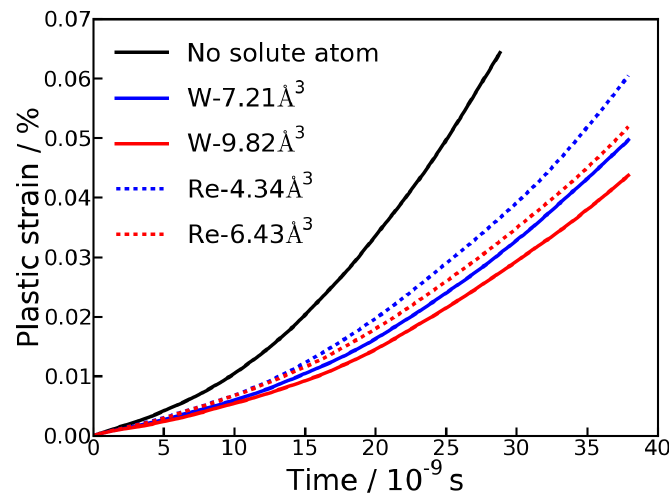
Figure 8. Plastic strains as a function of time for different excess volumes of Re and W for a concentration of 9 × 10 − 4 at.% under 500 MPa tensile load along the [001] direction at 850 ◦